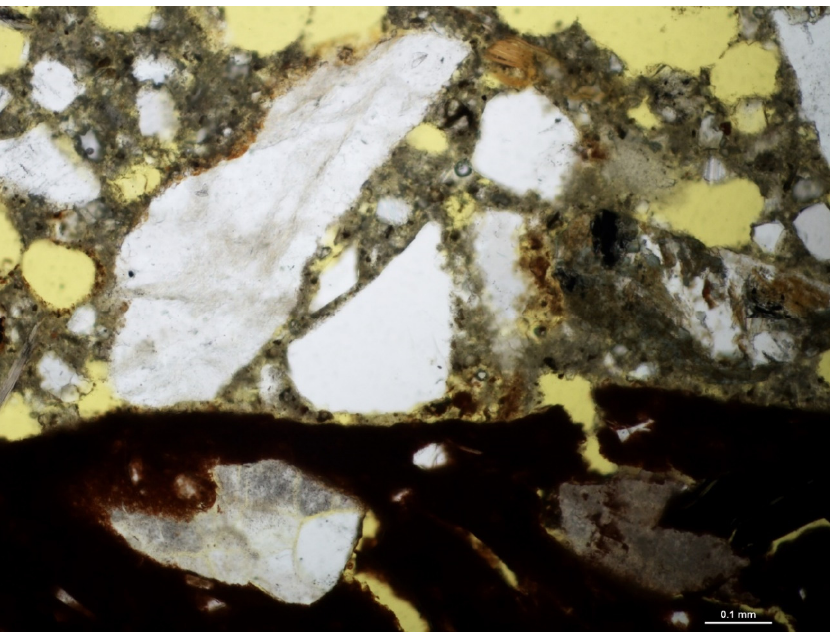
Figure 6. Microscopy image of a thin section; an area with good contact. The yellow parts are air voids, whilst the white parts are aggregate, and the contact zone is the interface between the dark and the charcoal-coloured cement paste.